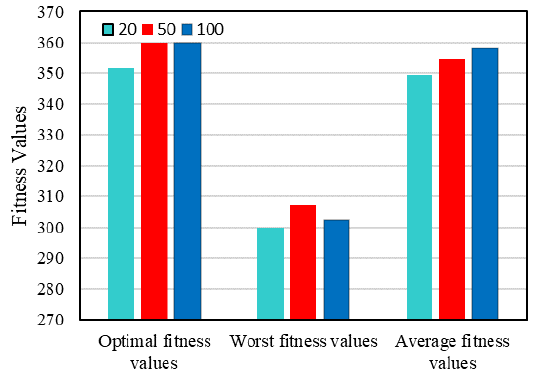
Figure 6. The relation of Population Size and Fitness Value.